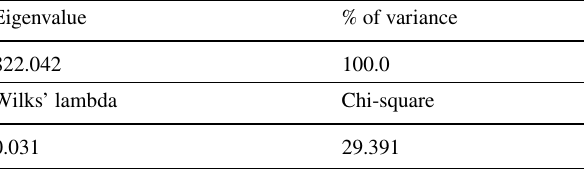
Table 2 Statistical summary for the discriminant function